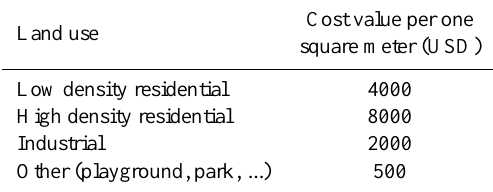
Table 5. Runoff coefficient of different land uses (ASCE,